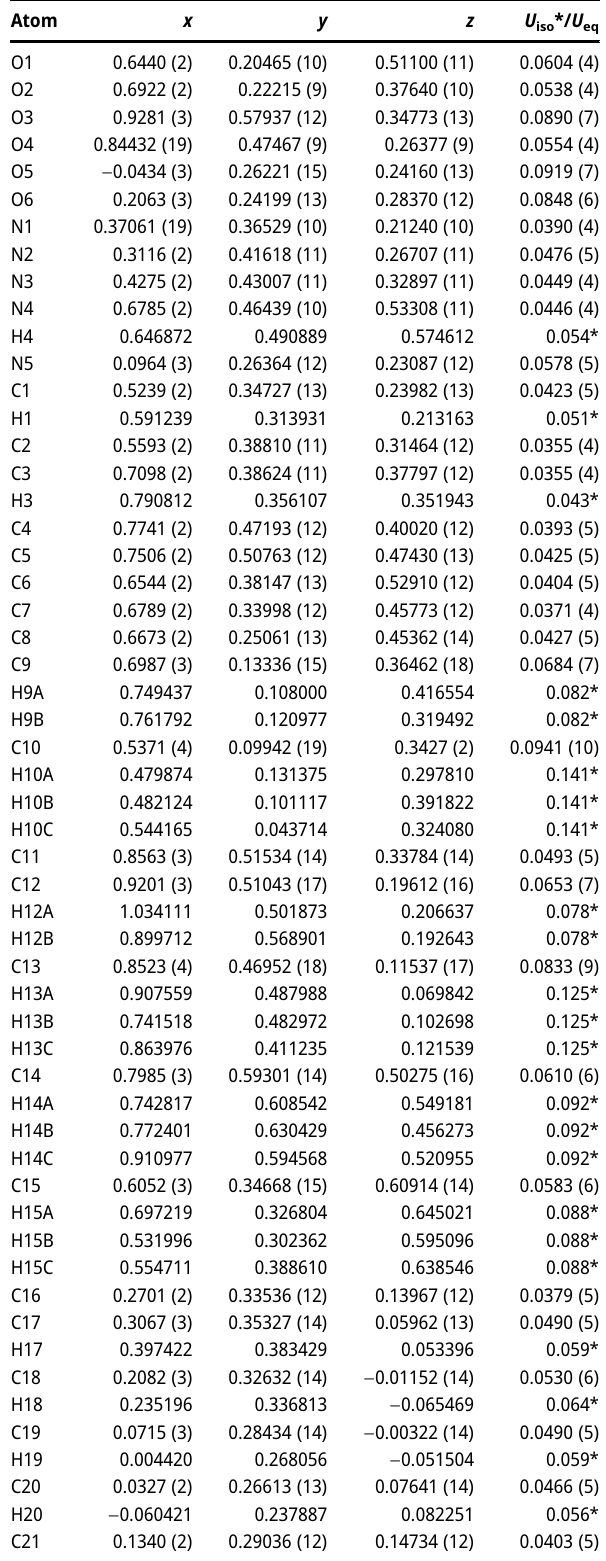
Table  : Fractional atomic coordinates and isotropic or equivalent isotropic displacement parameters (Å 